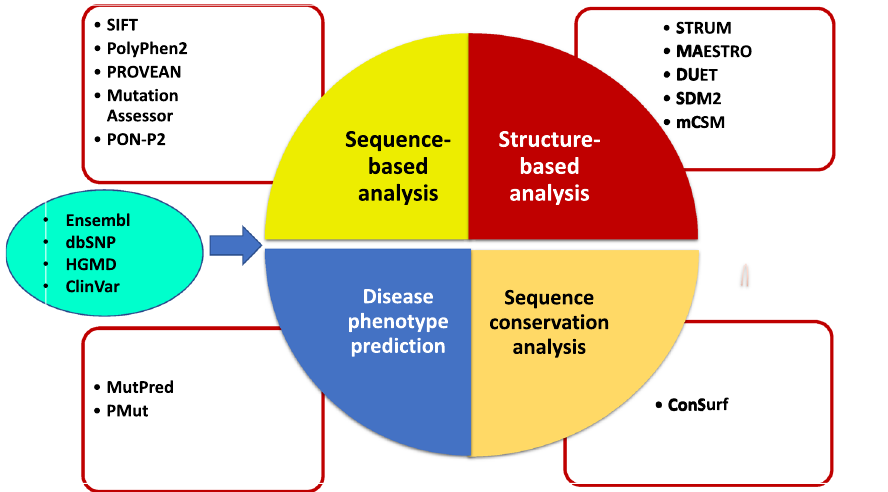
Figure 3. Overview of the used methods to predict the pathogenic mutations of the CTC1 protein at the sequence, structue and function